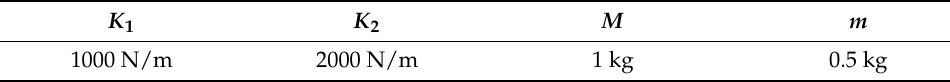
Figure 12. Schematics of a finite 1D mass-spring chain with attached local resonators. Table 1. Parameters of finite